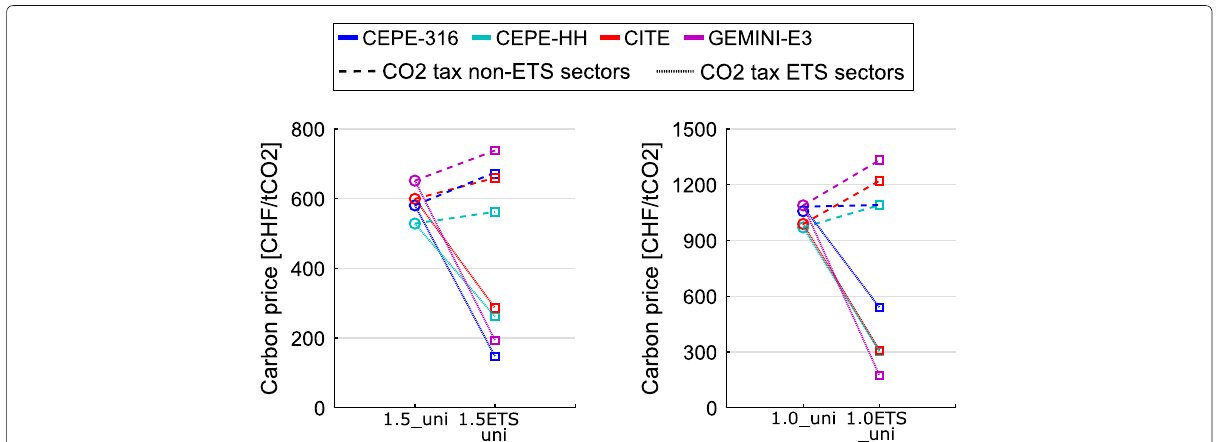
Fig. 8 ETS permit prices and carbon taxes for the scenarios 1.5_uni/1.0_uni and 1.5ETS_uni/1.0ETS_uni according to different